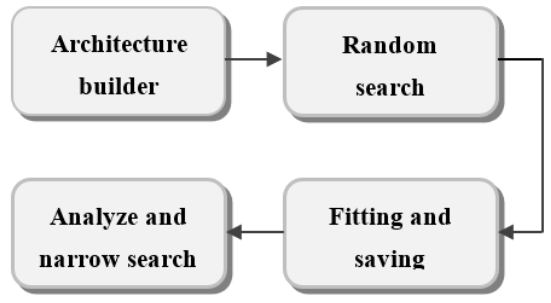
Figure 5. Diagram of the parameter selection process.